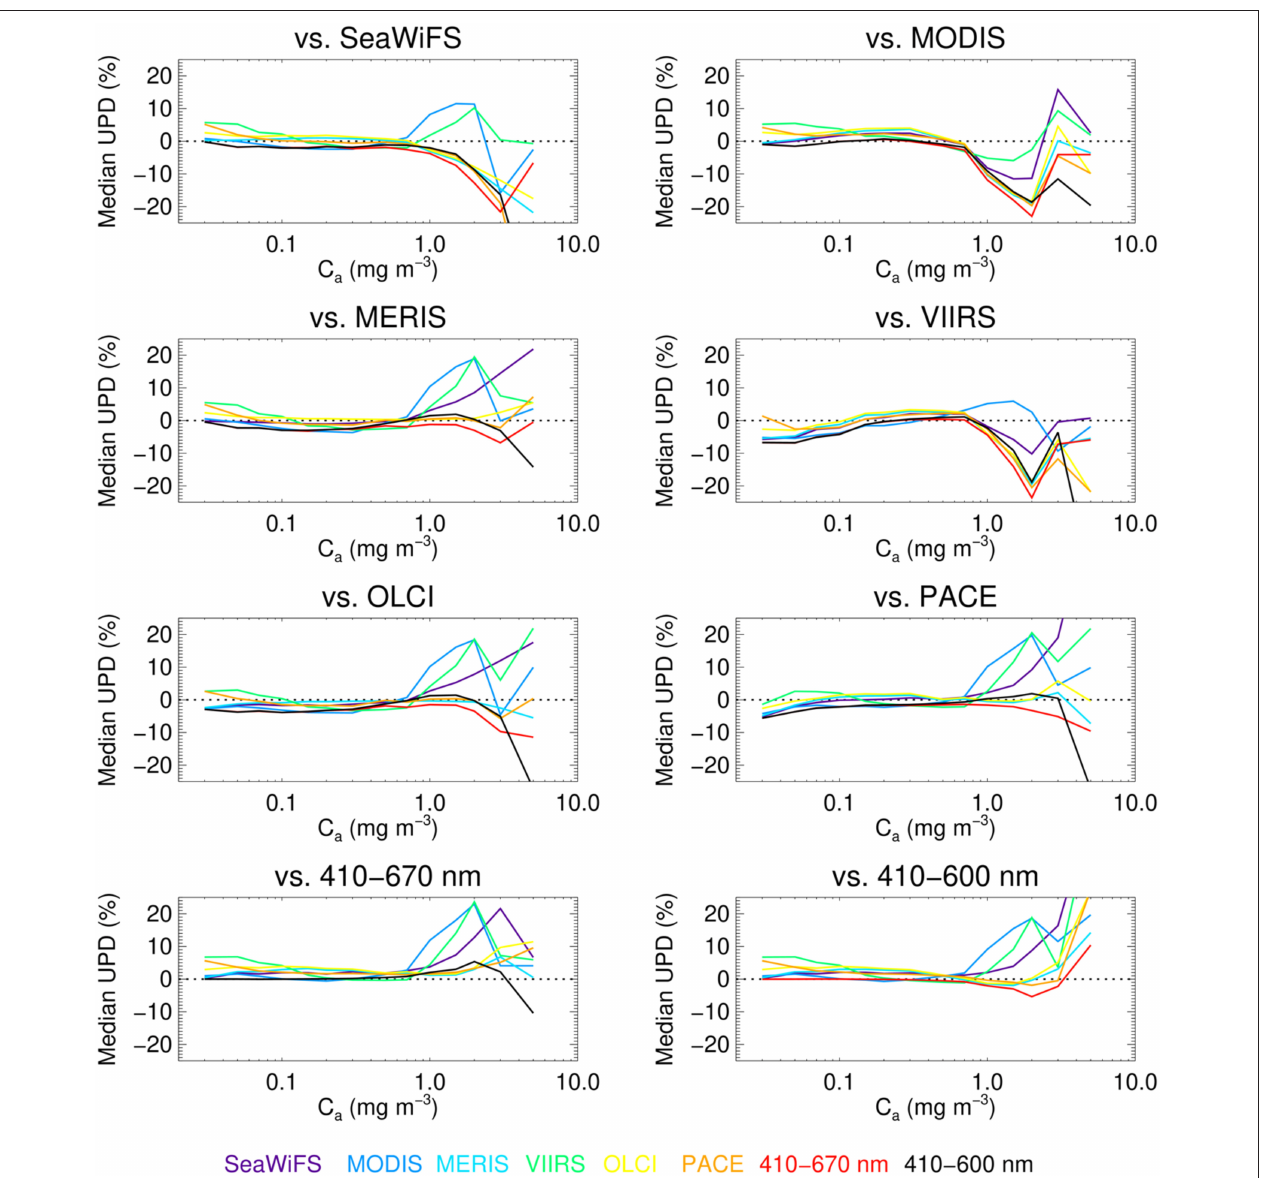
FIGURE 6 | As for Figure 3 , but for b bp